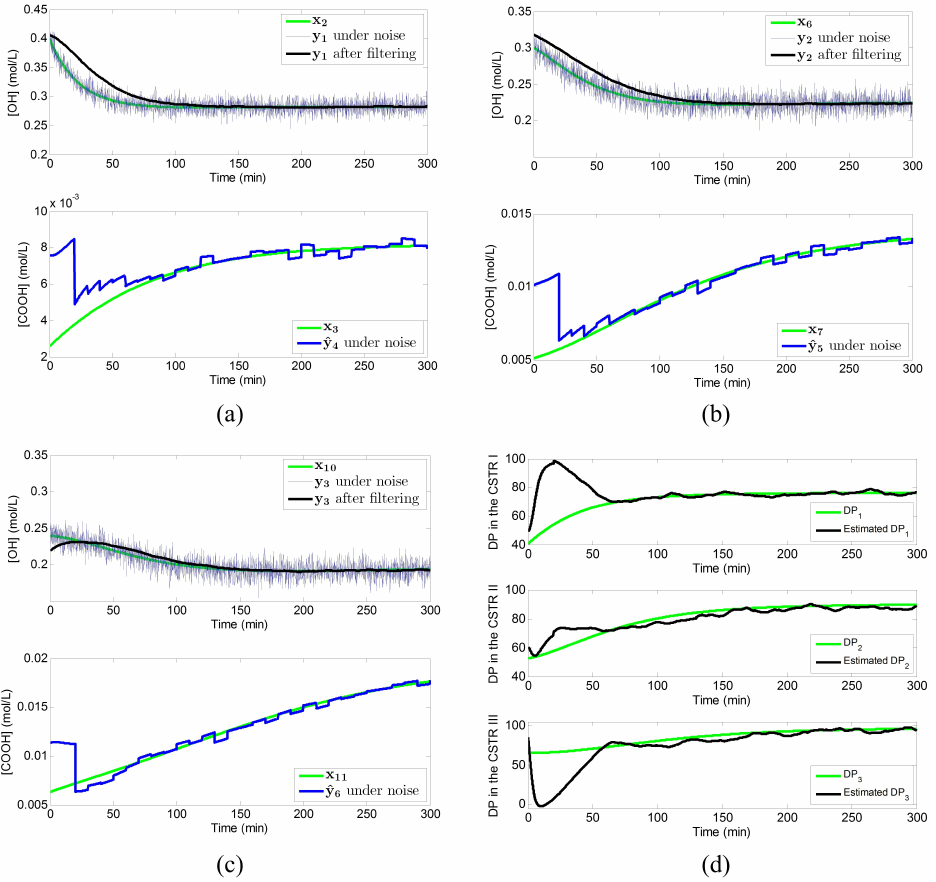
Figure 7. Measurement signals before (blue) and after (black) pre-filtering: ( a ) in CSTR I; ( b ) in CSTR II; ( c ) in CSTR III. Observer performance: ( d ) actual and estimated degree of polymerization in all three